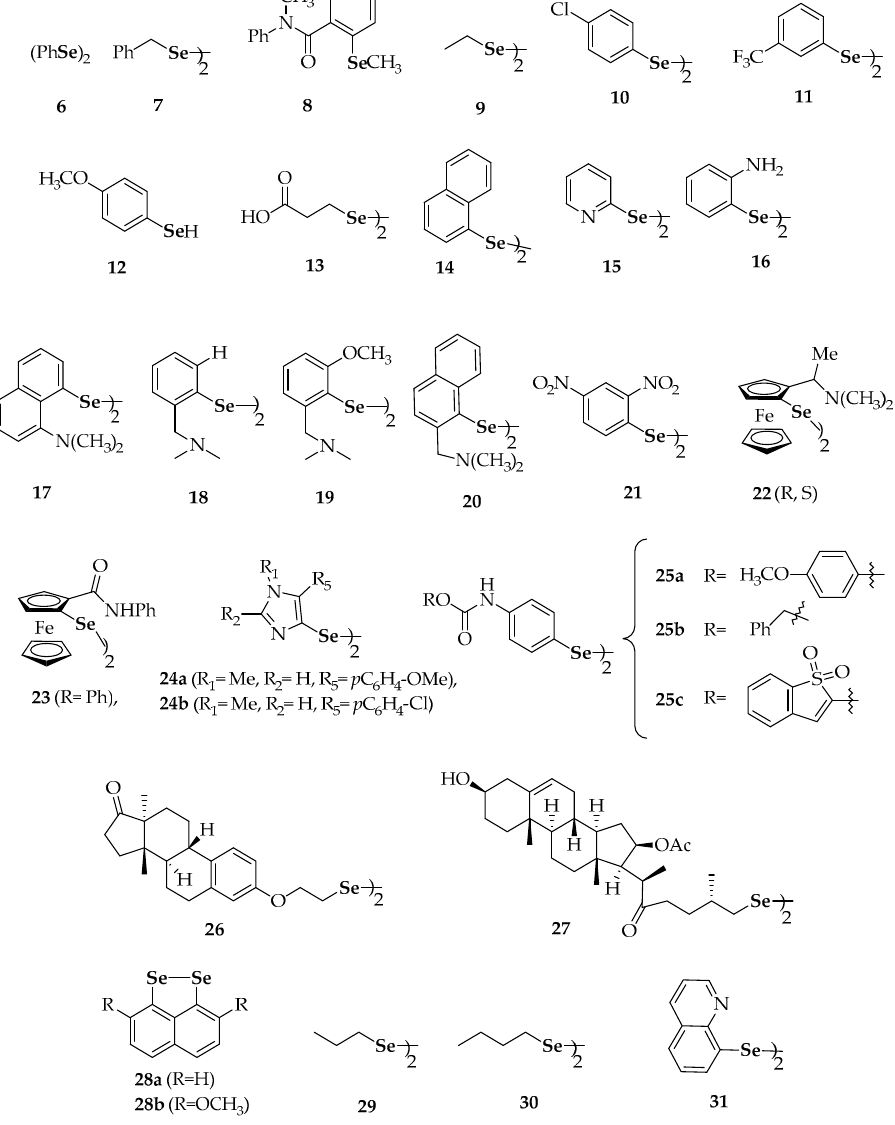
Figure 2. Synthetic diselenides and related selenides or selenols with antioxidant and/or